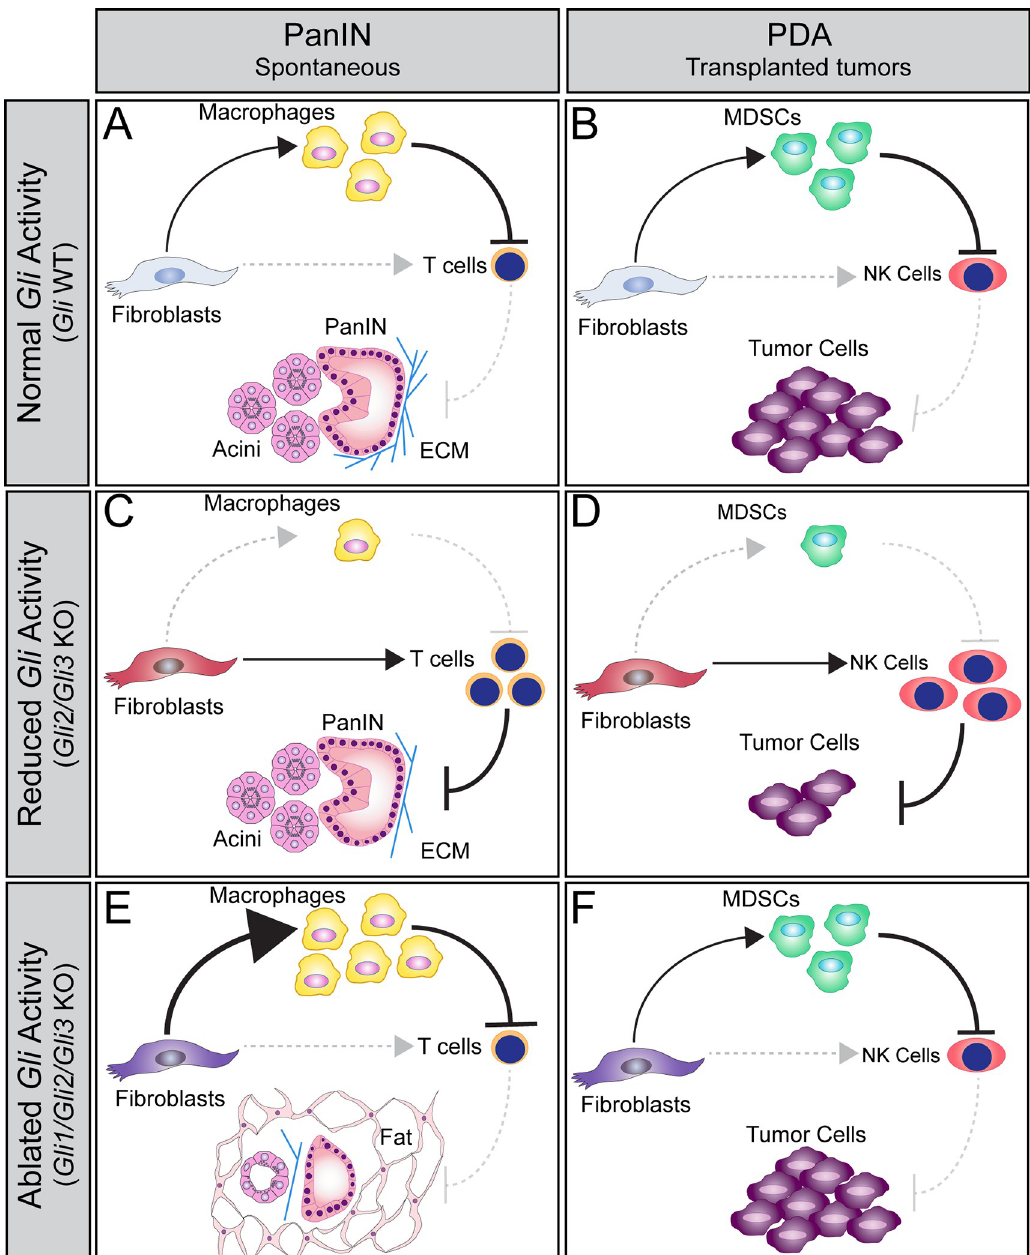
Fig 7. Model of GLI function during PDA progression. ( A-B ) Gli -expressing fibroblasts directly promote the recruitment of macrophages and MDSCs ( A,B , top) at PanIN and PDA stages, respectively. These myeloid cells suppress T cells and NK cells ( A, B , right), facilitating disease progression. ( C-D ) Gli2 and Gli3 deletion in fibroblasts directly reduces the recruitment of myeloid cells, and directly promotes T cell and NK cell infiltration ( C,D , right). Loss of Gli2 and Gli3 also decreases collagen deposition and slows tumor growth ( C,D , bottom). However, when all three Glis are deleted ( E , F ), fibroblasts have an enhanced ability to recruit macrophages ( E , top) and a sustained ability to recruit MDSCs ( F , top), leading to T cell and NK cell exclusion ( E,F , right). Thus, Gli1/Gli2/Gli3 KO fibroblasts support tumor growth ( F , bottom). Interestingly, loss of Gli1/Gli2/Gli3 also leads to the loss of pancreas tissue and an accumulation of fat at PanIN stages ( E , bottom), indicating that a baseline level of GLI activity is necessary to maintain pancreas